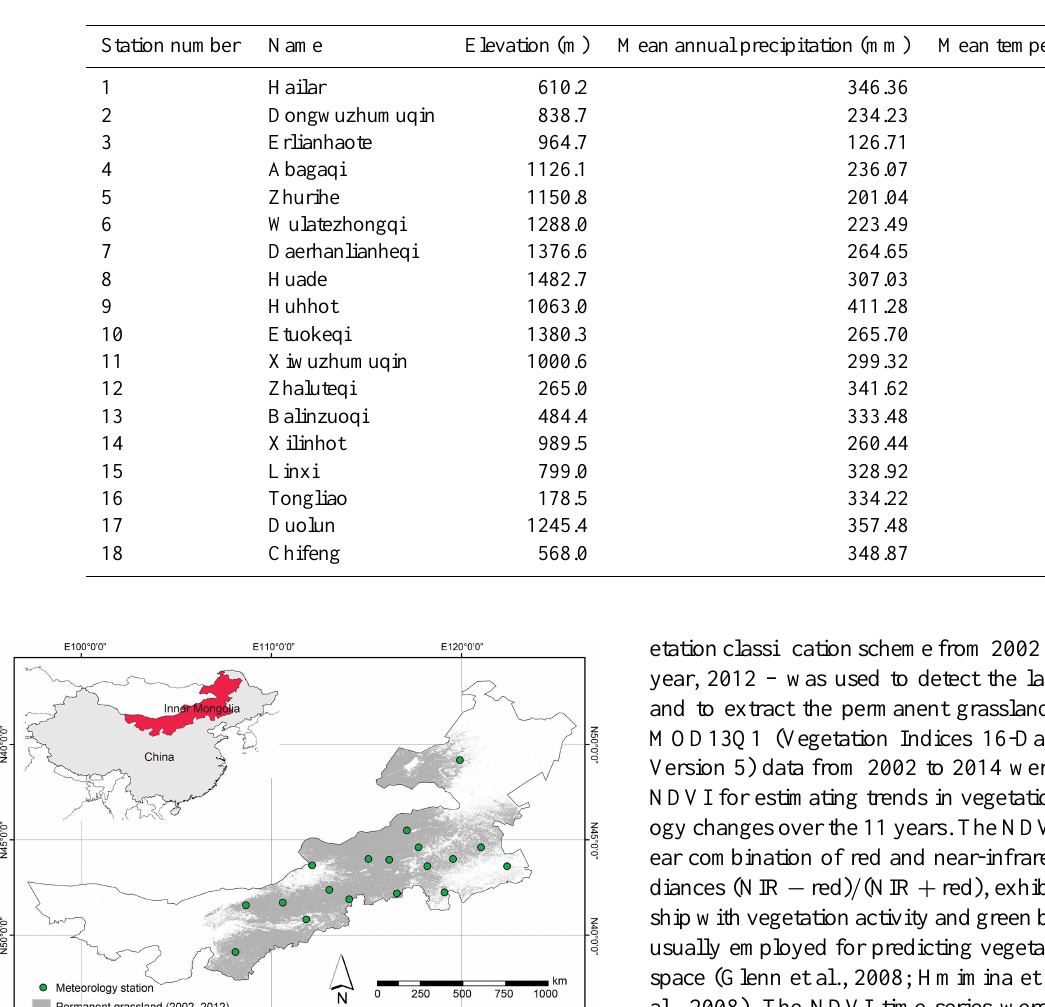
Table 1. Information on the meteorological stations.